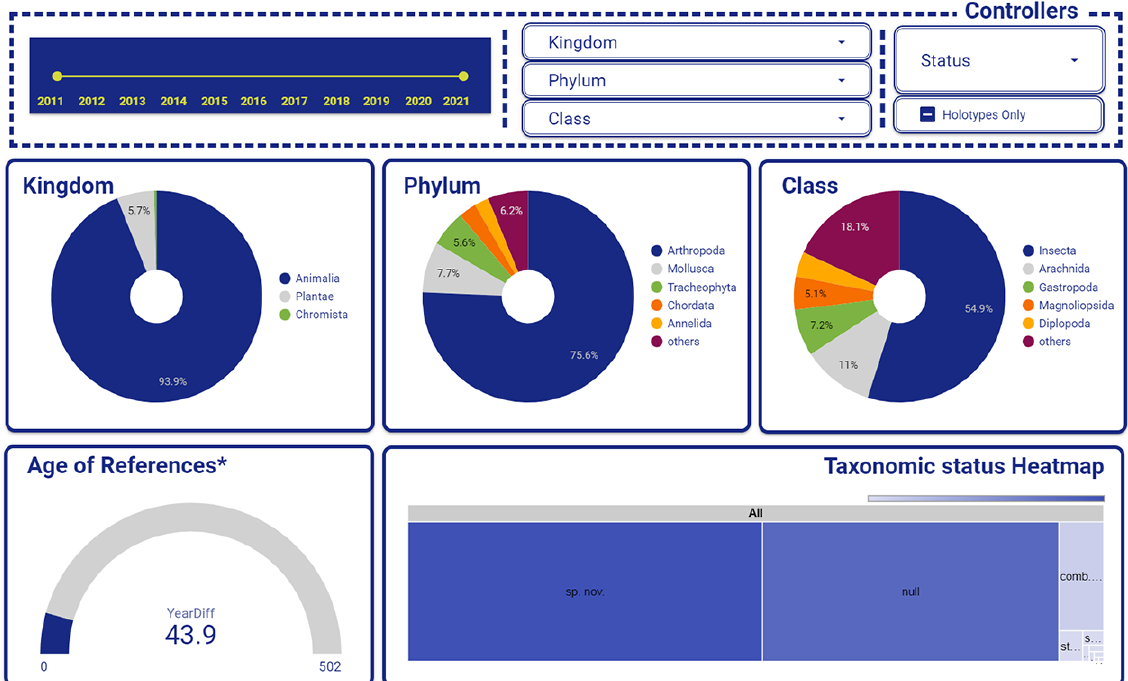
Fig. 6. Distribution of relative number of treatments by taxonomic rank. The average Age of Reference is the difference between the specimens cited in the material citations and the publications